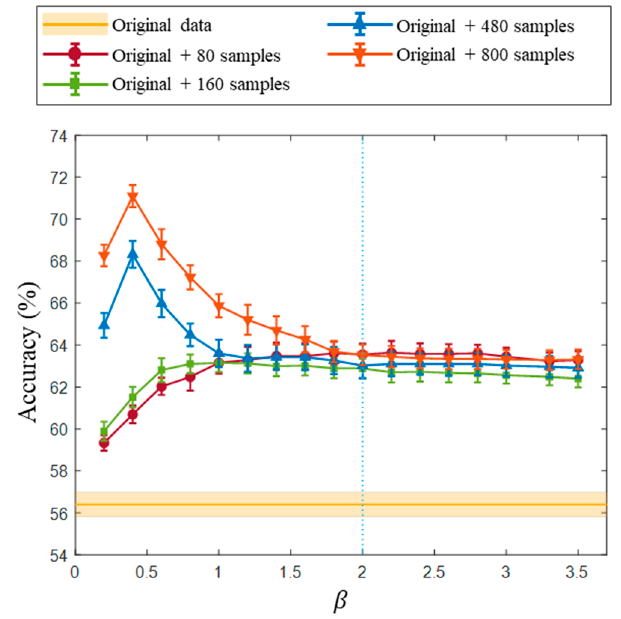
Figure 11. Classification accuracy of EMG data with GNDv1; the symbols and error bars represent the average accuracy and standard error, respectively.